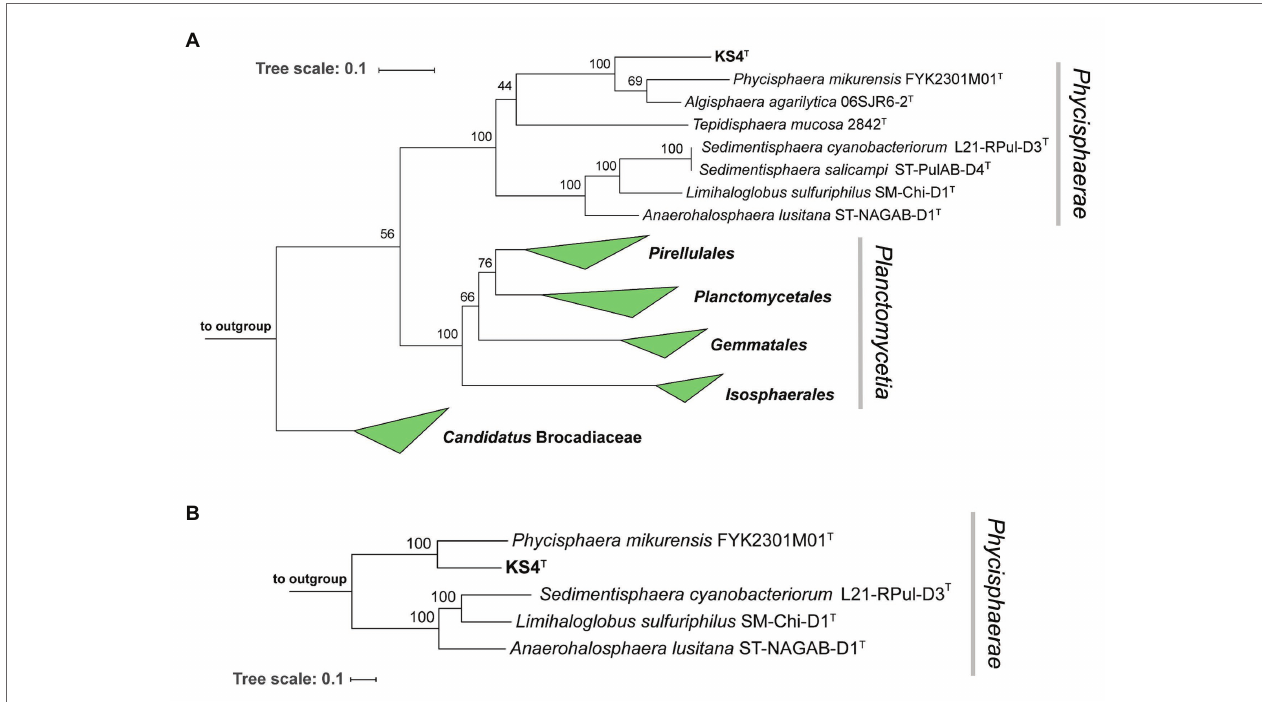
FIGURE 3 | Maximum likelihood phylogenetic analysis. Phylogenetic trees showing the position of strain KS4 T . 16S rRNA gene- (A) and multi-locus sequence analysis (MLSA)-based phylogenetic analysis (B) was performed as described in the Material and Methods section. Bootstrap values after 1,000 re-samplings (16S rRNA gene) or 500 re-samplings (MLSA) are given at the nodes (in %). The strains used as outgroup are provided in the Material and Methods section.